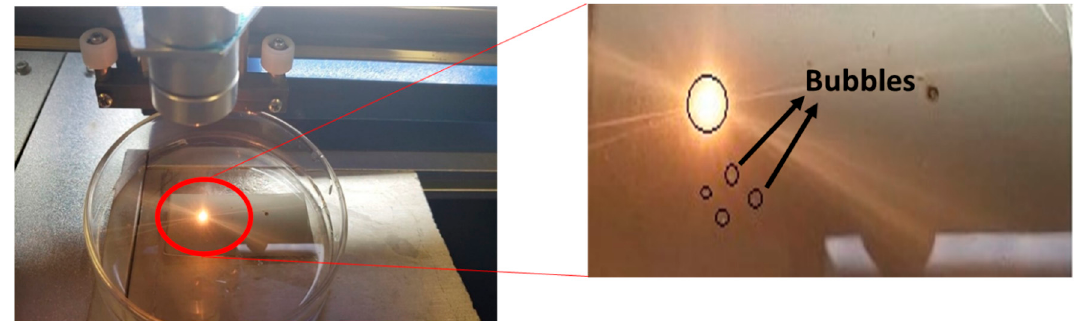
Figure 17. Bubble Formation during LA-LBMM Process Experimentation (Right side image shows the magnified view of the circled region).